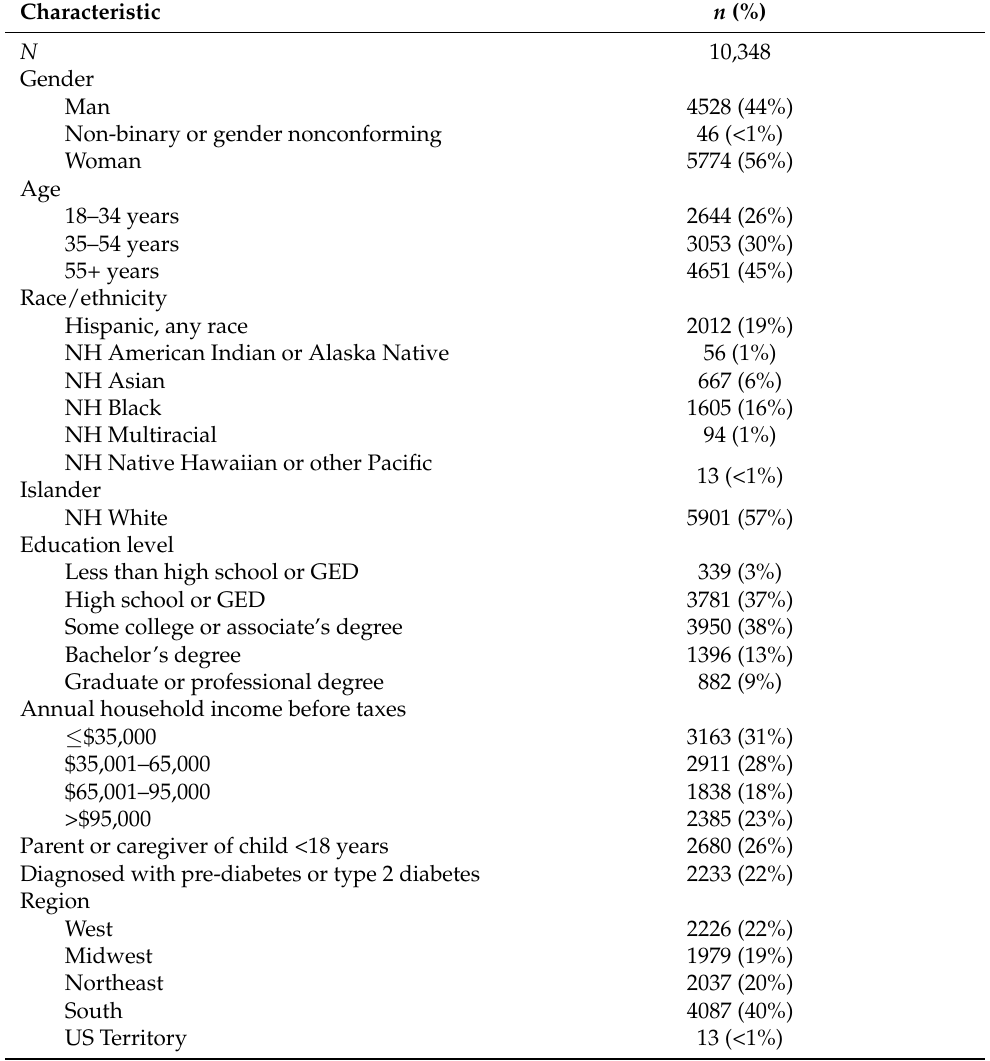
Table 1. Sociodemographic characteristics of a national sample of US